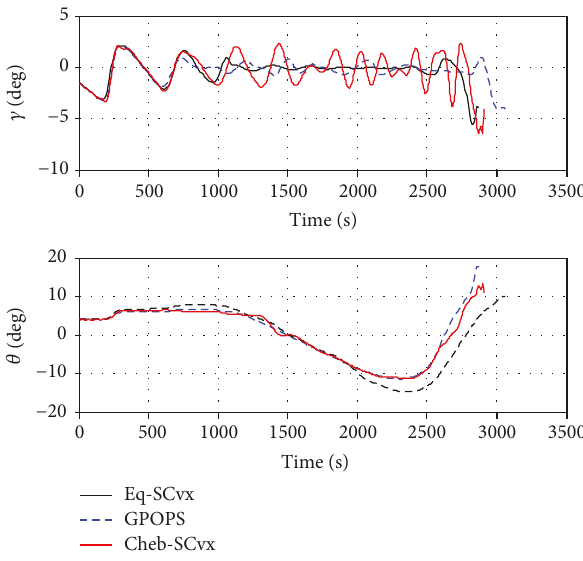
Figure 5: Control variables (normalized lift coe ffi cient and bank angle) histories.